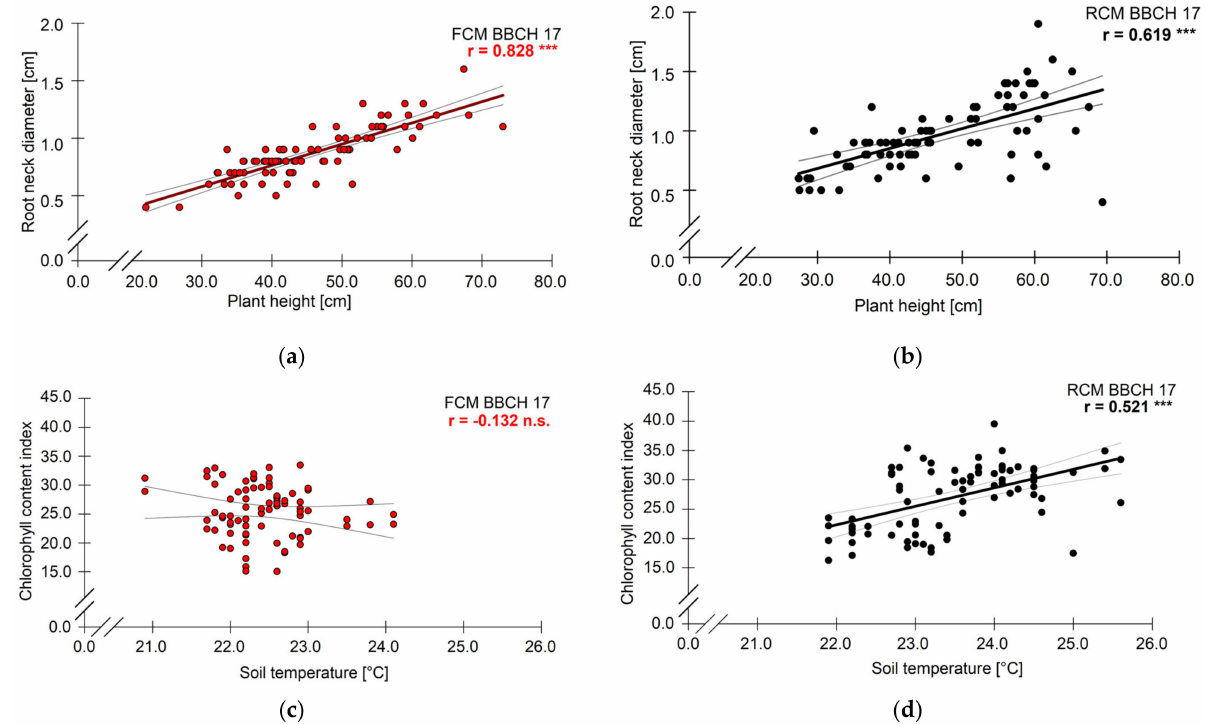
Figure 6. Pearson’s correlation during Environment Bergen 2020 (BR20) between plant height (PH) and root neck diameter (RND) during BBCH 17 (7 leaves unfolded): ( a ) in flat cultivation method (FCM), ( b ) in ridge cultivation method (RCM). Between chlorophyll content index (CCI) and soil temperature (ST) during BBCH 17 (7 leavs unfolded) ( c ) in FCM, ( d ) in RCM and between CCI and PH during BBCH 55 (middle of tassel emergence). n.s.- not significant. *** ( a – d ) indicatesignificance at p <